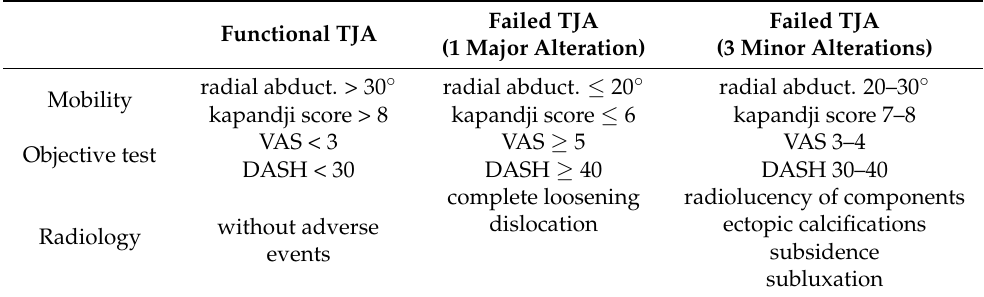
Table 1. The prosthesis was considered to be functional if the patient has no pain and no alterations in mobility, functionality and radiology and could use the hand normally for activities of daily living. The prosthesis was considered as failed if at least one of the major alterations occurred. The prosthesis was also considered failed if at least three or more minor alterations were